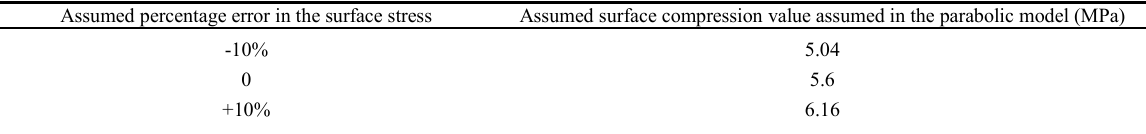
Table 2: Assumed surface residual stress values for 10 mm thick annealed glass test